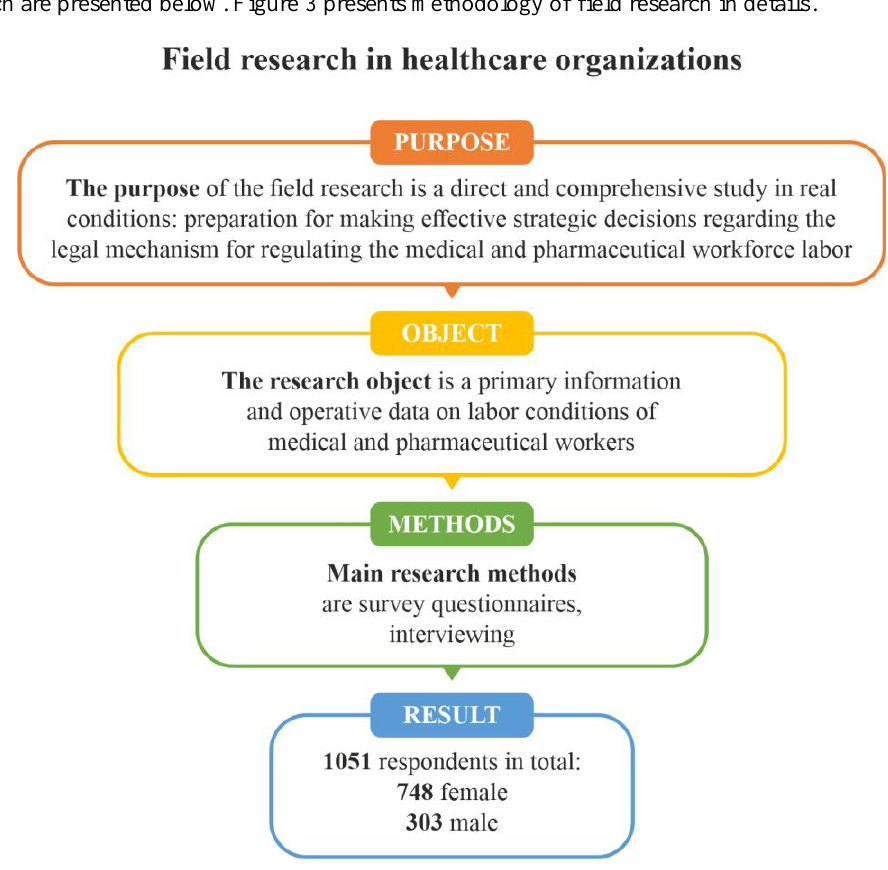
Figure 3. Methodology of field